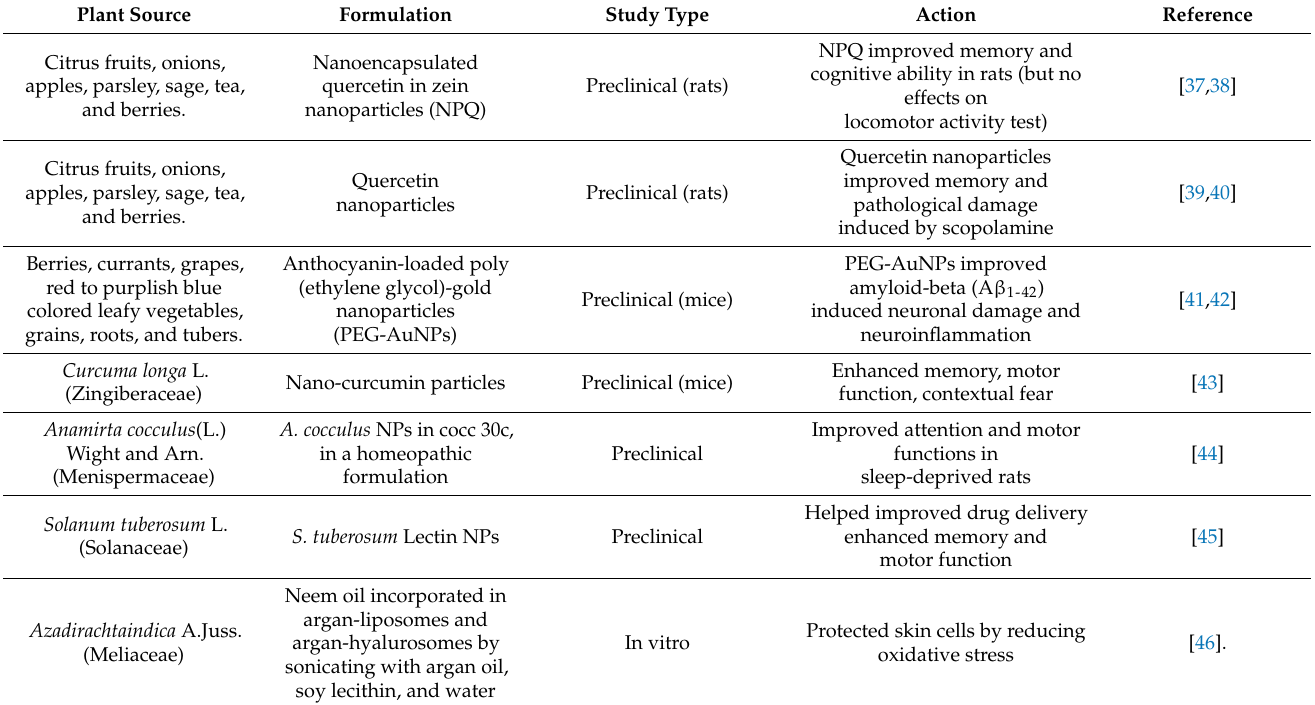
Table 1. Role of nano-phytopharmaceutical formulations against various locomotor, skin, and urogenital